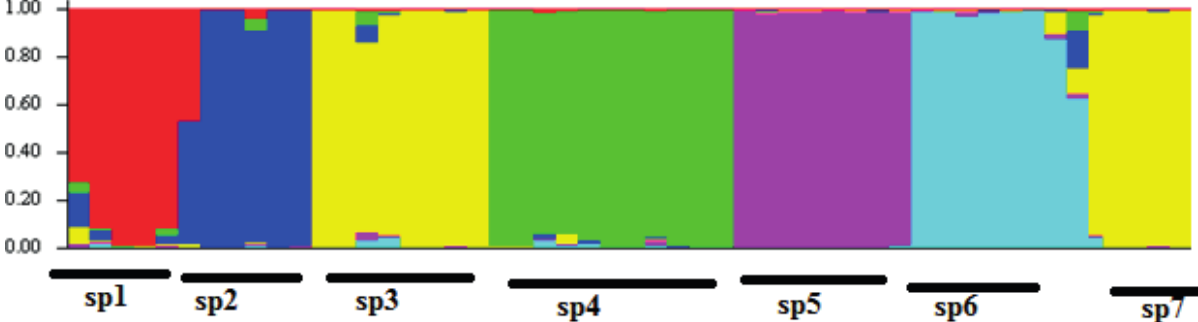
Figure 6. STRUCTURE plot of RAPD data in Malva populations s tudied. 1. Malva neglecta; 2. Malva parviflora; 3. Malva pusilla ; 4. Malva sylvestris; 5. Malva verticillata; 6. Malva nicaeensis; 7. Malva